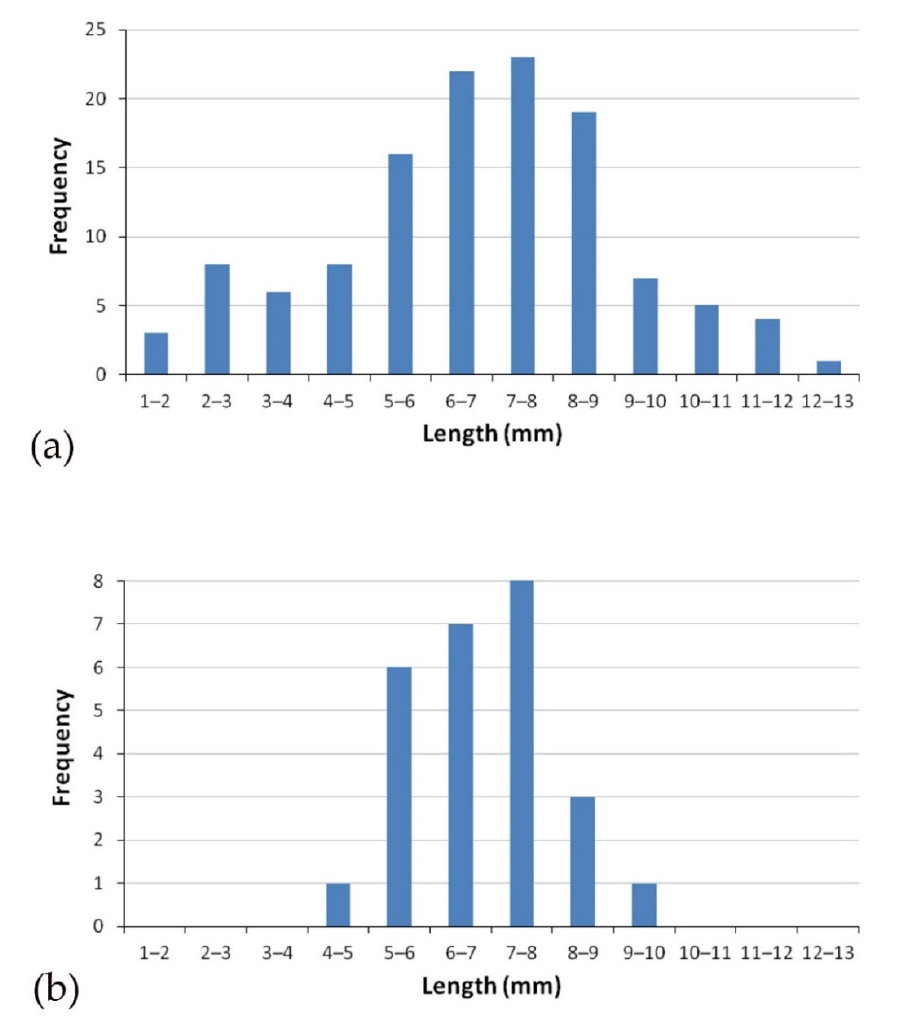
Figure 5. Size distribution of Rocellaria dubia shell length: ( a ) 122 individuals from all samples; ( b ) 26 individuals from the most infested oyster.